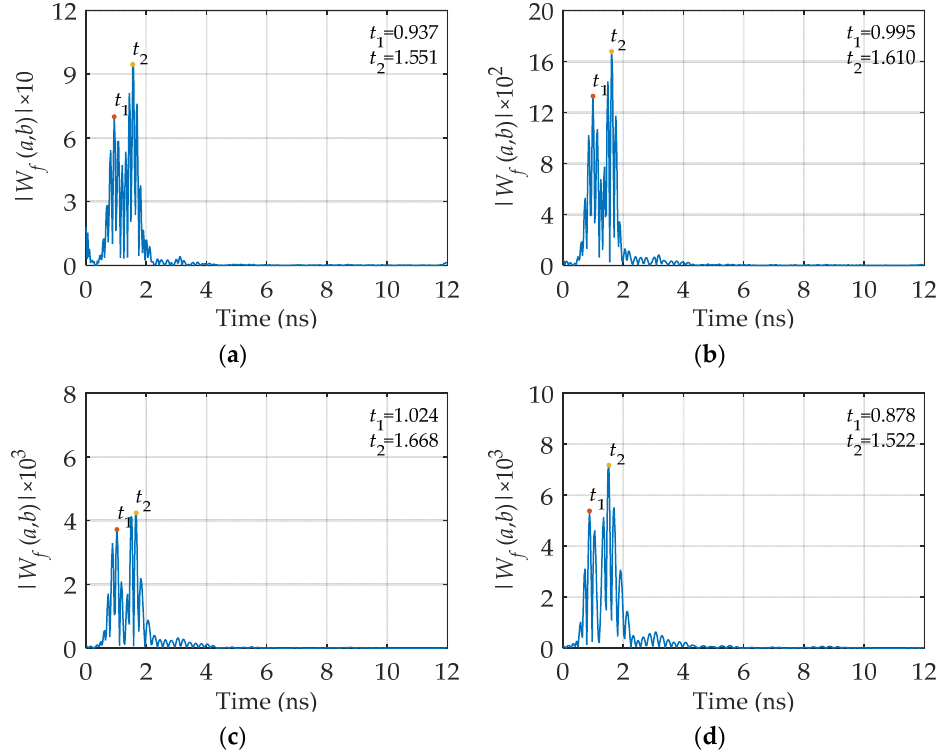
Figure 17. Modules curves of wavelet transform coefficients obtained by using wavelet transform for typical single-channel signal on the survey line y 2 , under different stretch scales: ( a ) a = 2; ( b ) a = 4; ( c ) a = 6; ( d ) a = 8.